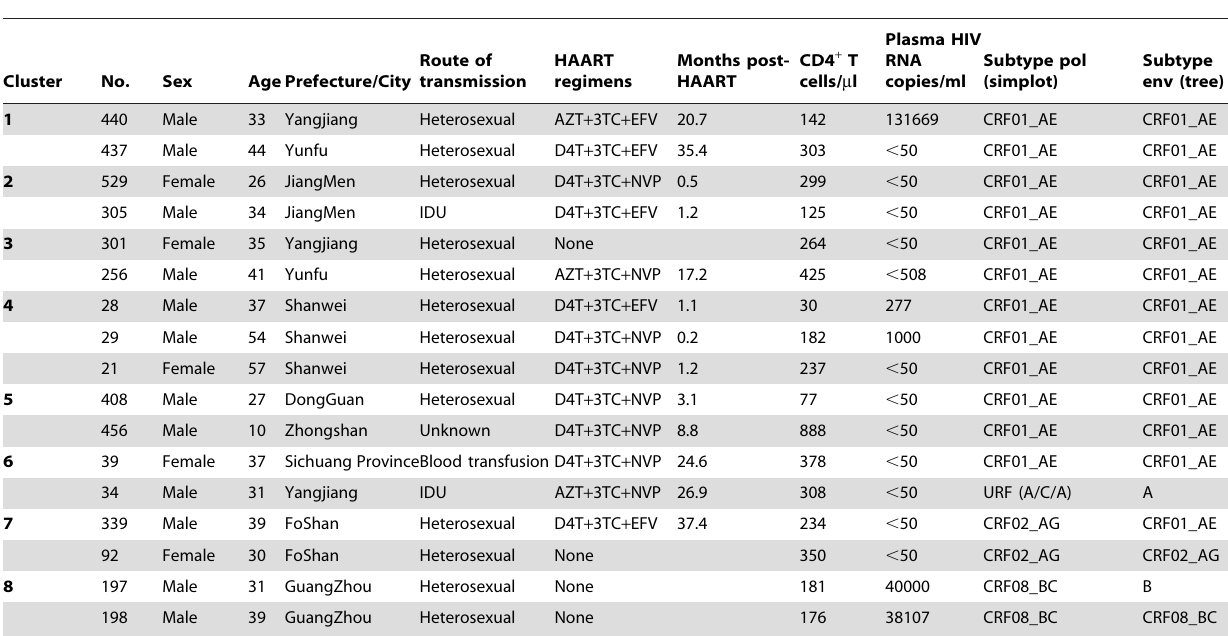
Table 4. Characteristics of patients showing pol sequences within the 10 transmission clusters identified by phylogenetic